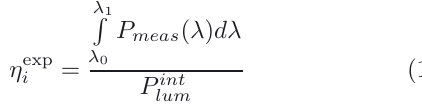
Fig. 4. Er 3+ calibrated emission spectrum excited at 1.54 μ m for CYF ( P exc = 65 mW) (a) and Z18 ( P exc = 75 mW) (b); Absolute conversion efficiency as a function of the 1.5 μ m ex- citation power density